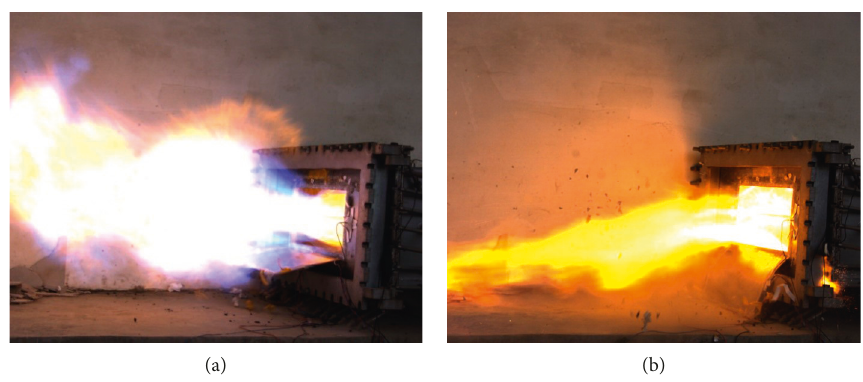
Figure 26: Partial enlarged